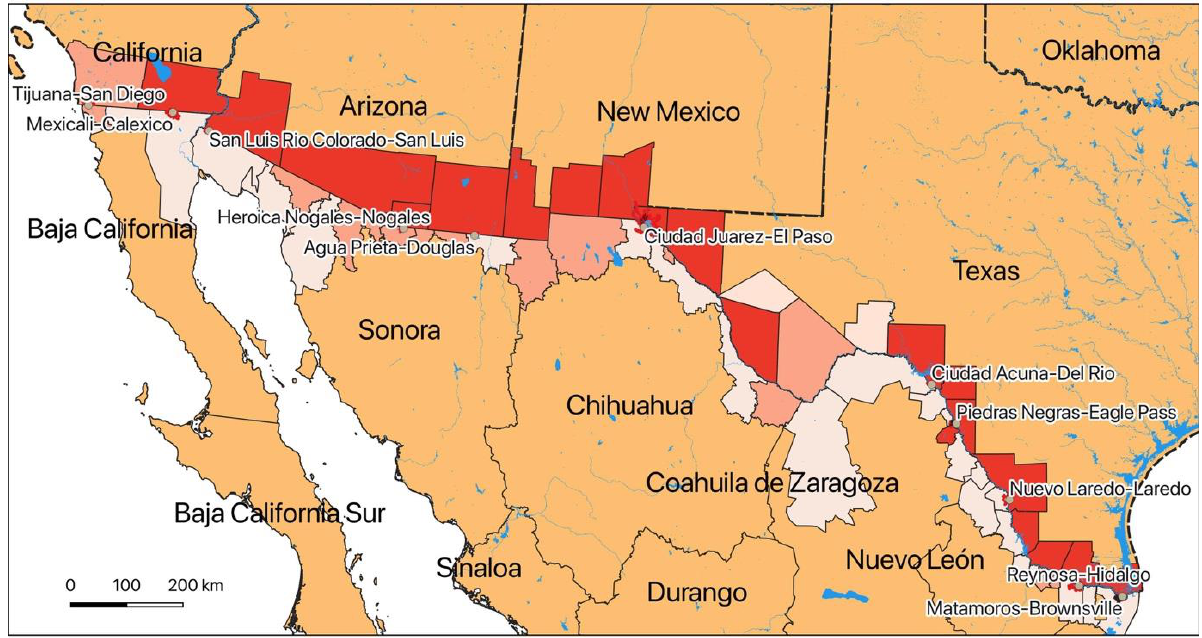
Figure 5. SVI 2010 for municipios in Mexico (CONABIO) and counties in the USA (CDC) along the shared border of both countries. Darker colors (red) represent higher vulnerability (data sources: Table A2).